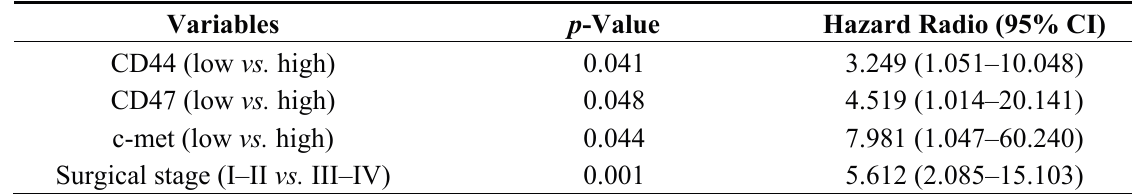
Table 3. Multivariate analysis of the prognosis of patients with